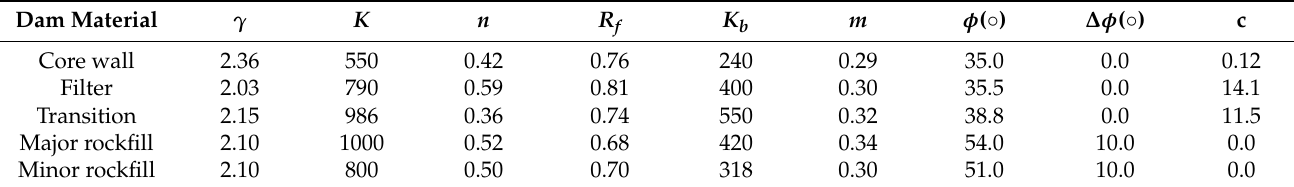
Table 2. The EB model parameters of the main materials in Pubugou